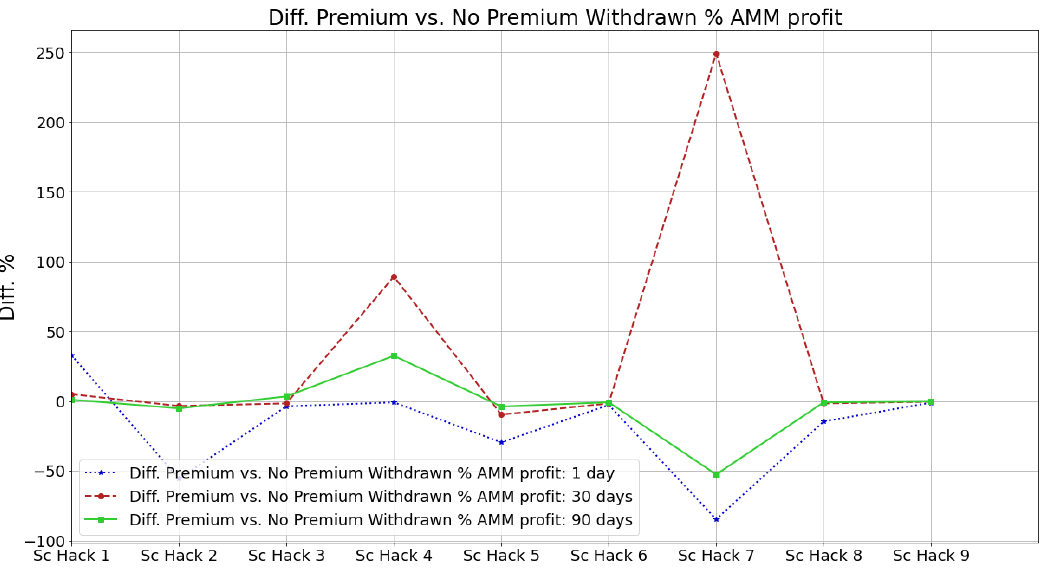
Figure 10. Premium vs. No Premium Withdrawn rkAMM profit difference from hack